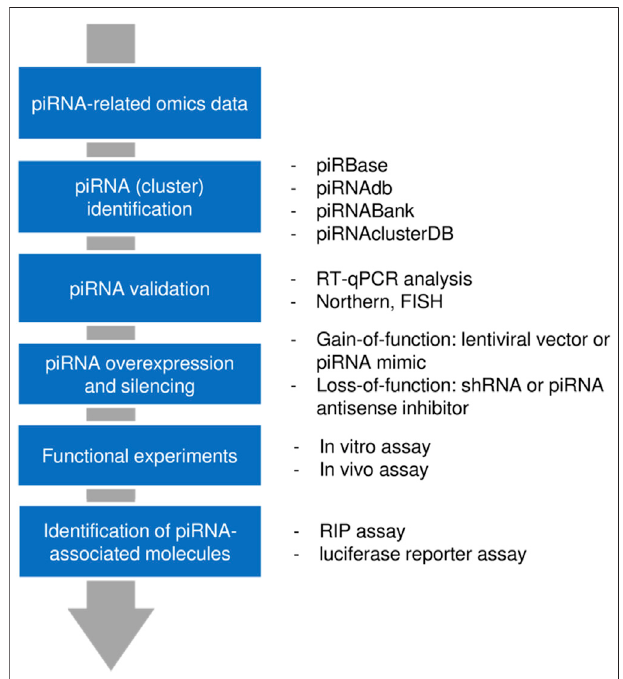
FIGURE 1 | Work fl ow for piRNA discovery and analysis. First, a candidate piRNA was identi fi ed from a pool ofRNAs through high-throughput approaches.Aftervalidation,gain-of-functionorloss-of-functionmodels were generated and the functionalimpact of apiRNA wasassessed. By using pulldown assay or reporter assay, those molecules that interact with piRNAs (proteins or RNAs) could be